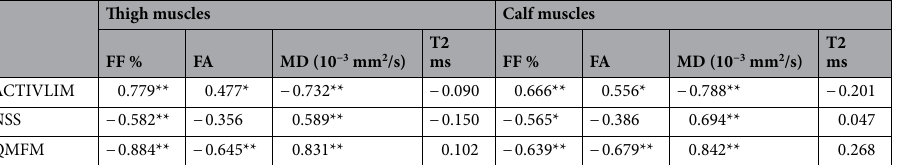
Table 4. Overview of Spearman rank correlation coefficients for qMRI parameters fat fraction (FF), fractional anisotropy (FA), mean diffusivity (MD), and T2 relaxation time (T2) and clinical outcome measures in calpainopathy patients. * p < 0.05, ** p < 0.01.